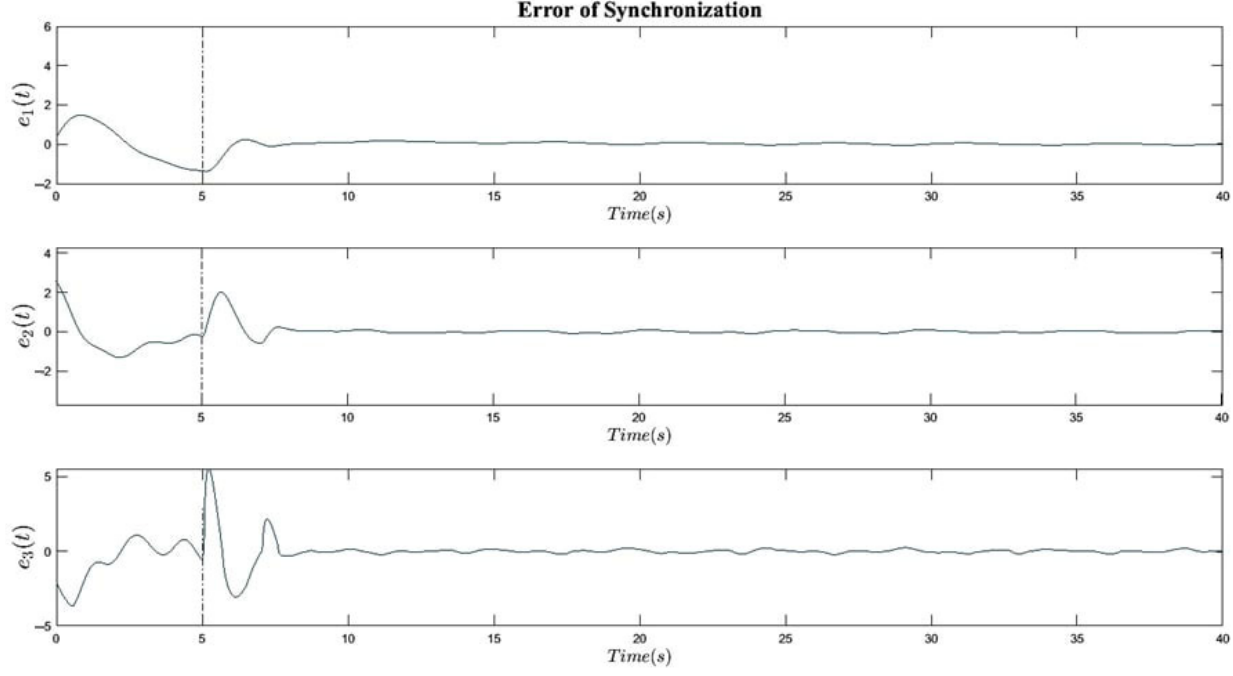
Figure 4. Synchronization error of the master and slave systems.